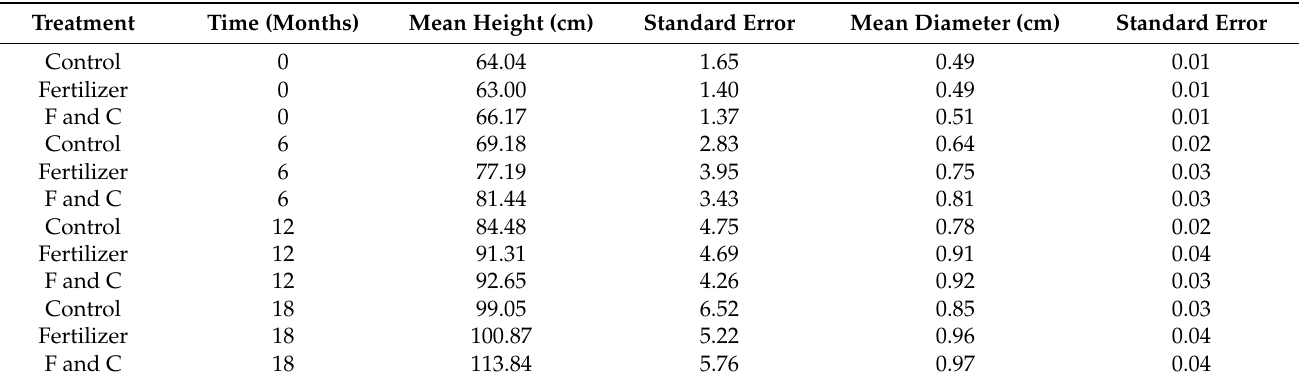
Table A1. Average height and diameter and associated standard errors as a function of time steps. F